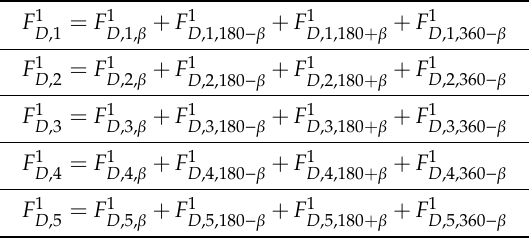
Table 1. Exciting forces and moments on a vertical cylindrical body in front of an orthogonal breakwater.